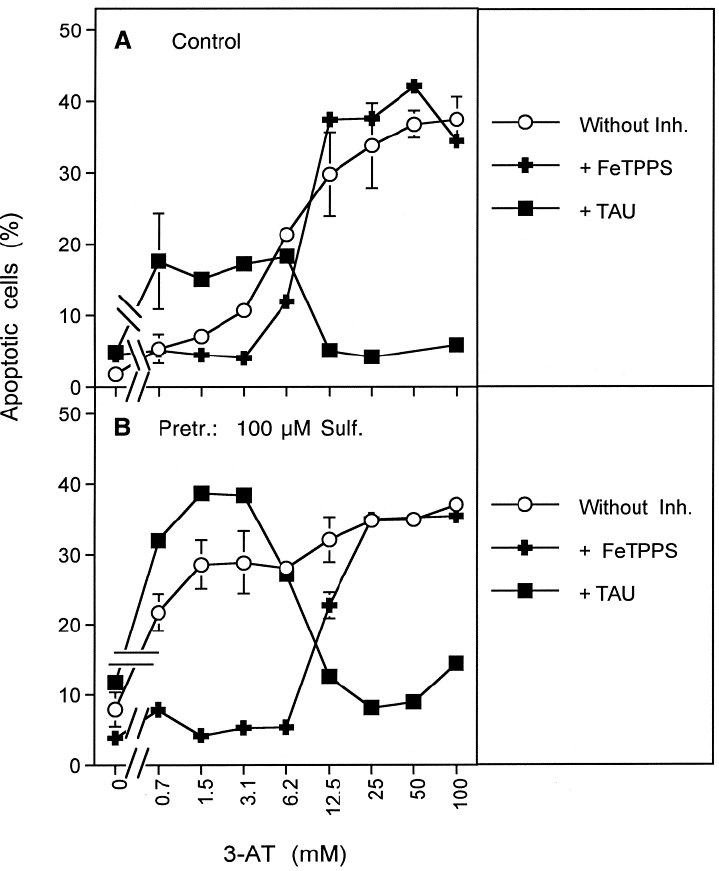
Figure 11. Quality of ROS/RNS signaling in controls and after sulfasalazine pretreatment. MKN- 45 cells (200,000 cells/mL) were pretreated for 14 h in the absence of sulfasalazin (control) ( A ) or presence of 100 µ M sulfasalazine ( B ). After pretreatment, cells were washed and reseeded at a density of 12,500 cells/well in 96 well tissue culture clusters. Assays were kept without additional inhibitors or in the presence of 20 µ M FeTPPS or 50 mM taurine. 3-AT was added at the indicated concentrations and the percentages of apoptotic cells were determined after 5 h incubation. At concentrations of 3-AT of 12.5 mM and higher, HOCl signaling prevailed in the assays described in ( A , B ). At lower concentrations of 3-AT, NO/peroxynitrite signaling was dominant. Pretreatment with sulfasalazine caused an enhancement of NO/peroxynitrite signaling. Statistical analysis. The effect of sulfasalazine pretreatment on apoptosis induction by low concentrations of 3-AT was highly significant ( p < 0.001). The differential inhibition by FeTPPS and taurine was highly significant ( p < 0.001). 3-AT-mediated apoptosis induction in control cells was strongly inhibited by the aquaporin inhibitor Ag + (Figure 12A), whereas apoptosis induction in cells pretreated with 100 µ M sulfasalazine was not affected at all by Ag + (Figure 12D). In tumor cells that had been pretreated with intermediary concentrations of sulfasalazine (25 µ M, 50 µ M), the inhibitory effect of Ag + was also intermediary (Figure 12B,C). Thereby, inhibition by Ag + was more prominent in the lower concentration range of 3-AT and the range of 3-AT that allowed inhibition by sulfasalazine became lower with an increasement of the sulfasalazine